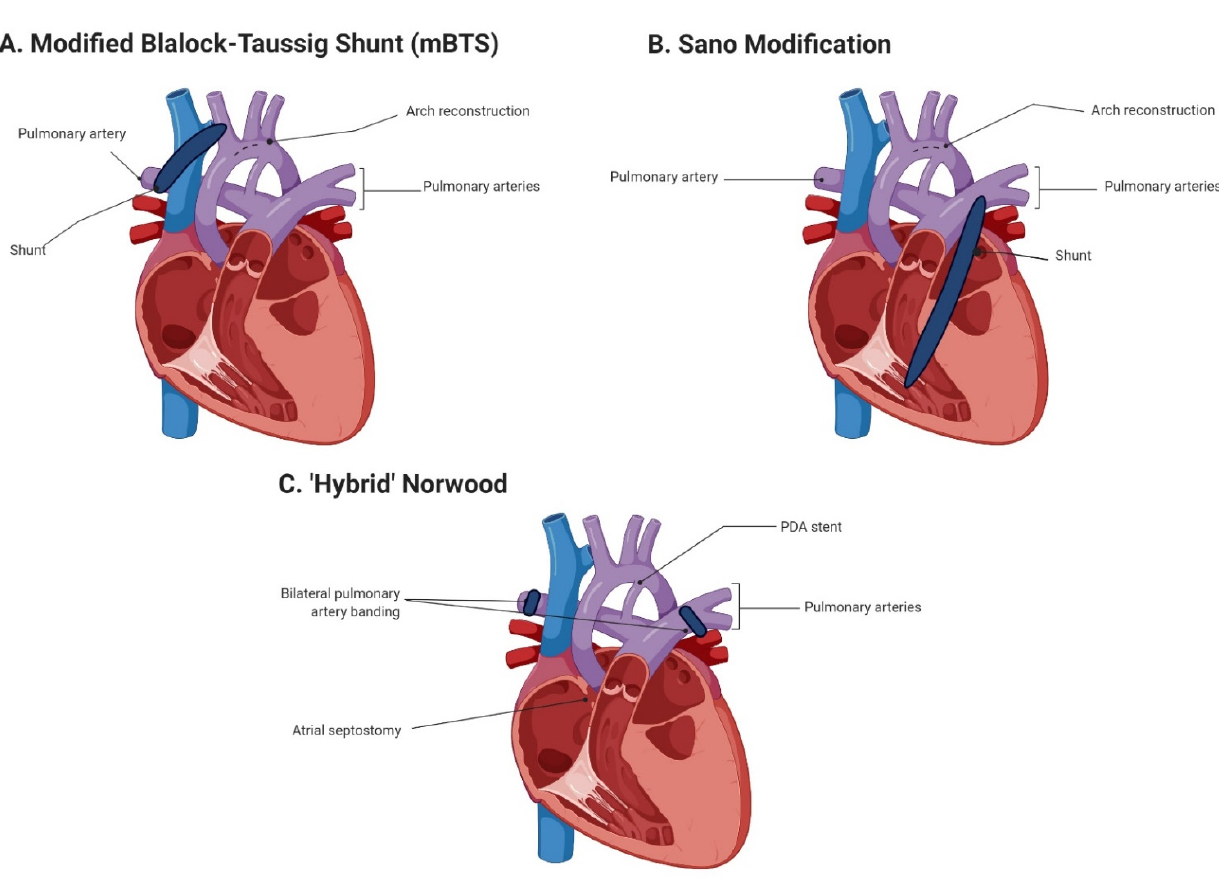
Figure 2. Current surgical options for Norwood Stage I palliation. PDA: patent ductus arteriosus. Created by Biorender.com (accessed on 3 June 2022).